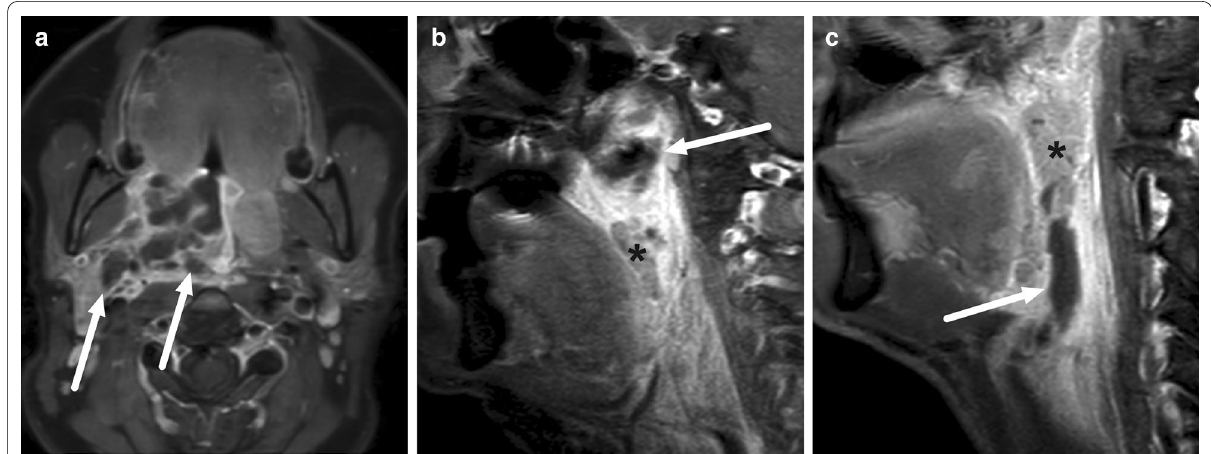
Fig. 16 Examples of deep extension of PTAs on axial ( a ) and sagittal ( b , c ) fat-suppressed post-contrast T1-weighted images. Abscesses (arrows) can extend posterolaterally ( a ), superiorly ( b ), or inferiorly ( c ) from the tonsil